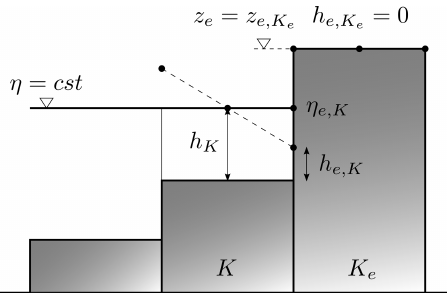
Figure A1. Typical situation of desired well-balanced property in the presence of a wet–dry front. The WS elevation is here denoted by η